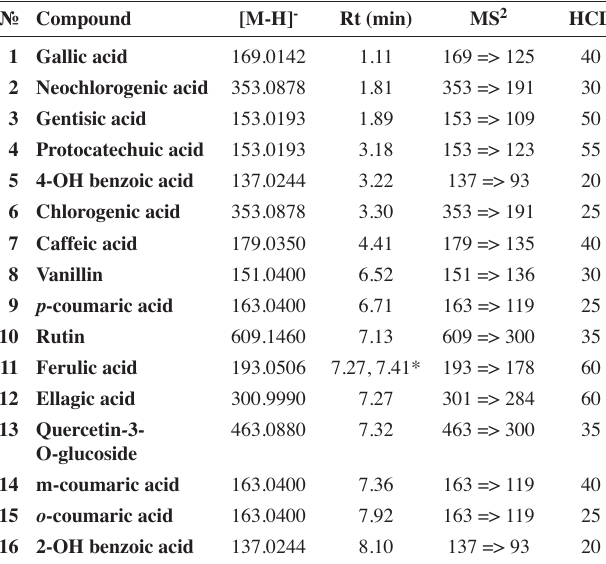
Tab. 3: Mass spectrometric and chromatographic